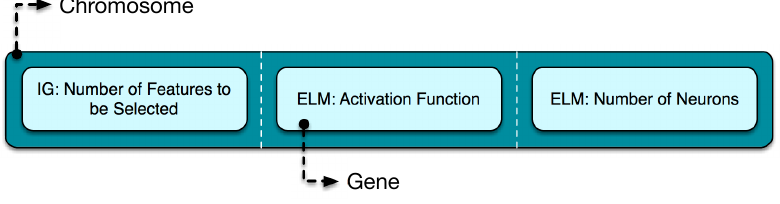
Figure 4. The chromosome used during the multi-objective optimization